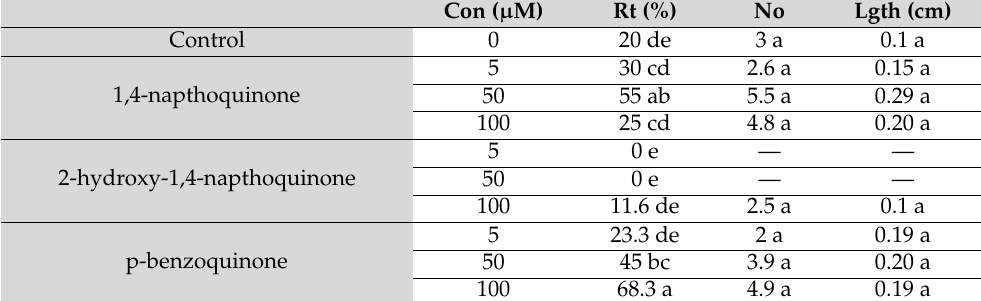
Table 3. Effect of 1,4-napthoquinone; 2-hydroxy-1,4-naphthoquinone; and p-benzoquinone on rooting variables of explants cultivated in rooting medium in the presence of IBA.